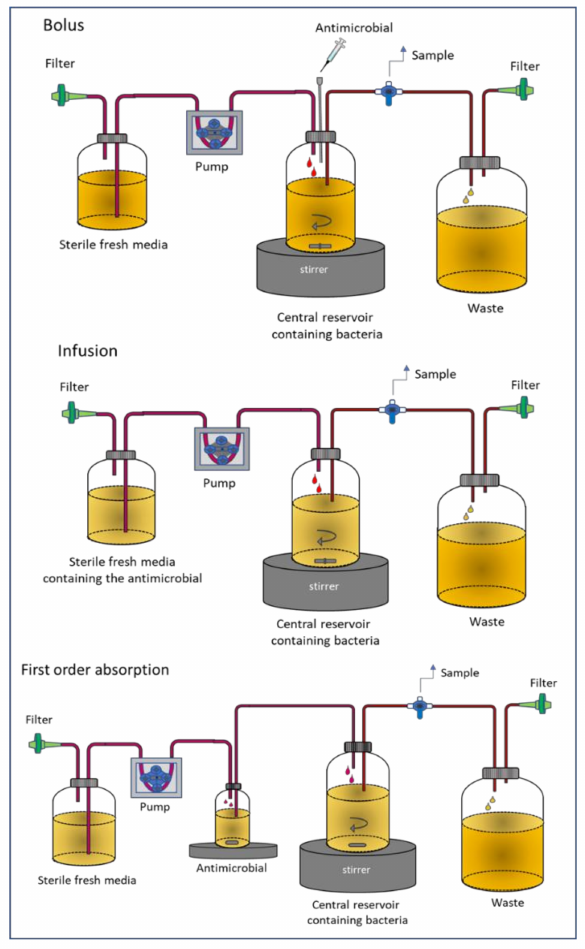
Figure 1. Dynamic one-compartment in vitro infection model (chemostat). This model has shown to be useful in evaluating bacterial killing and regrowth with antibiotics in monotherapy, and combinations as well. In a recent study, the efficacy of ceftolozane-tazobactam in combination with colistin against extensively drug-resistant Pseudomonas aeruginosa , including high-risk clones, was evaluated using the chemostat system [25]. The authors observed an additive or synergistic interaction for ceftolozane -tazobactam with colistin, and particularly against resistant strains. The chemostat system has some limitations, including elimination of bacteria, contamination of the medium, incomplete oxygenation, and accumulation of waste products over time